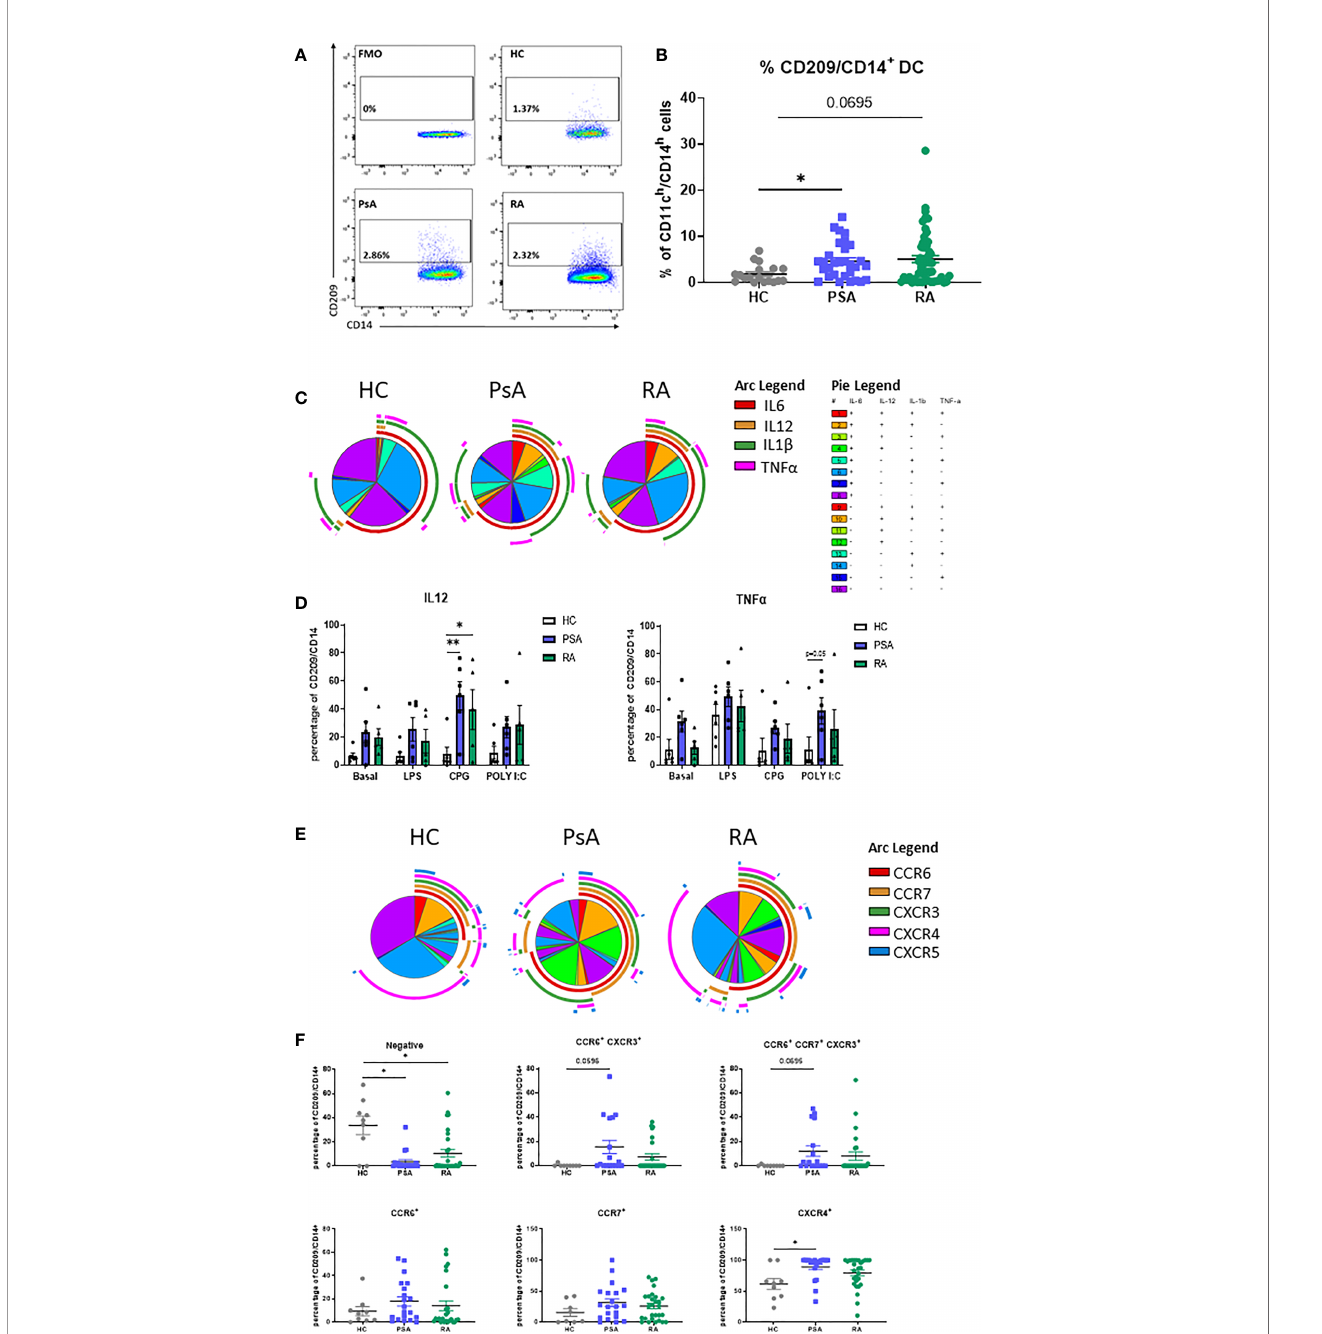
FIGURE 1 | Circulating CD209/CD14 + DC and PsA patients display an active pro fi le. PBMC from HC, PsA and RA patient were isolated and gated as per Supplementary Figure 1B . (A) Representative fl ow plot of FMO, HC, PsA and RA PBMC gated for circulating CD209/CD14 + DC. (B) Representative dot-plot showing the frequency of CD209/CD14 + DC, showing the frequency of the parent population (CD11c h /CD14 h ) in HC (n=19), PsA (n=30), RA (n=52) (C) SPICE algorithm fl ow cytometric analysis of unstimulated (basal) PBMC HC (n=6), PsA (n=6) and RA (n=5) CD209/CD14 + DC intracellularly stained for IL6 (red arc), IL12 (yellow arc), IL1 b (green arc), TNF a (pink arc). (D) Representative histogram of PBMC cells left untreated (basal) or stimulated for 3 hours with LPS (100ng/ml) CPG ODN 2216 (3µM) or Poly (I:C) (10ug/mL) in the presence of Brefeldin A and Monensin. Data are represented as mean ± SEM and differences among groups were evaluated by two-way ANOVA with Tukey post-test. *p < 0.05, **p < 0.01. (E) SPICE algorithm fl ow cytometric analysis of peripheral blood HC (n=9), PsA (n=20) and RA (n=29) CD209/CD14 + DC expression displaying the frequency showing the frequency of the parent population (CD209/CD14 + ) of the chemokines receptors CCR6 (red arc), CCR7 (yellow arc), CXCR3 (green arc), CXCR4 (pink arc) and CXCR5 (blue arc) and corresponding (F) Dot plot of negative population (cells not expressing chemokine receptors), CCR6 + CXCR3 + , CCR6 + CCR7 + CXCR3 + , CCR6 + , CCR7 + , CXCR4 + expressing cells. Data are represented as mean ± SEM and differences among groups were evaluated by non-parametric One-way ANOVA, Kruskal-Wallis test *p <